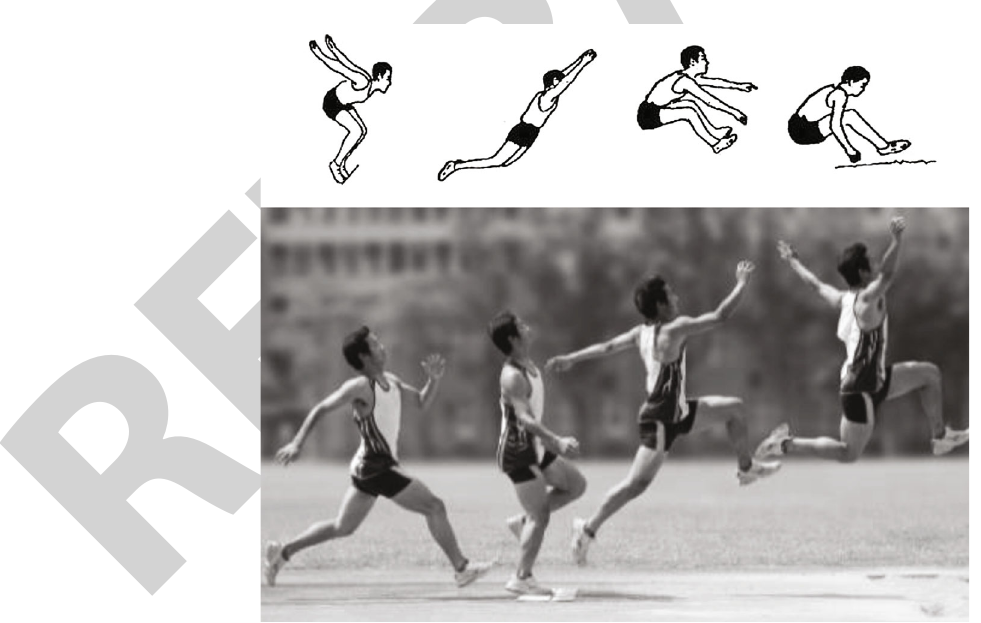
Figure 4: The four components of long